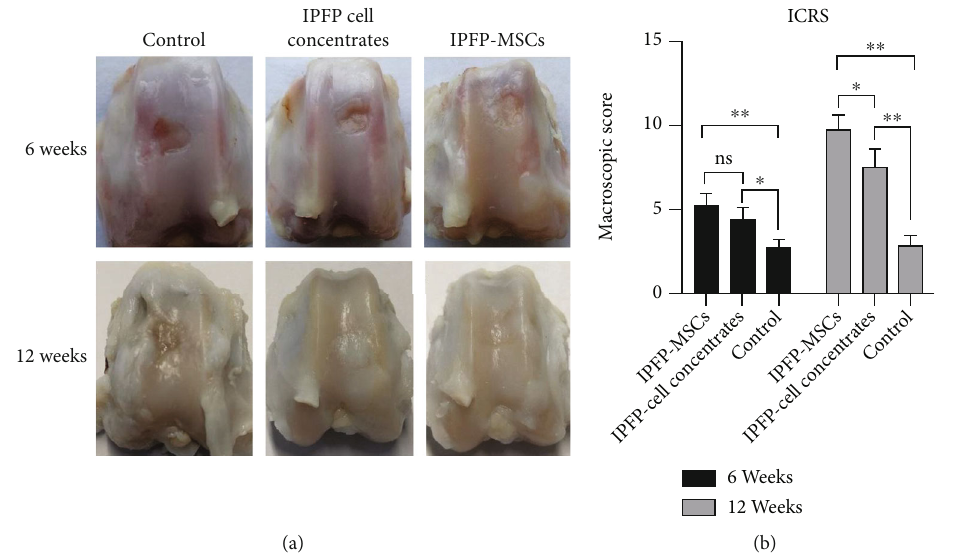
Figure 4: (a) The gross appearance of cartilage repair in vivo at 6 and 12 weeks after surgery. (b) The ICRS macroscopic evaluation scores of articular cartilage repair. (All data were expressed as the mean ± standard deviation (SD). Comparisons were performed with the Student t -test or one-way ANOVA for experiments with more than two subgroups. Asterisks indicate signi fi cant di ff erences ( ∗ P < 0 : 05 ; ∗∗ P < 0 : 01 ) compared with the corresponding control).